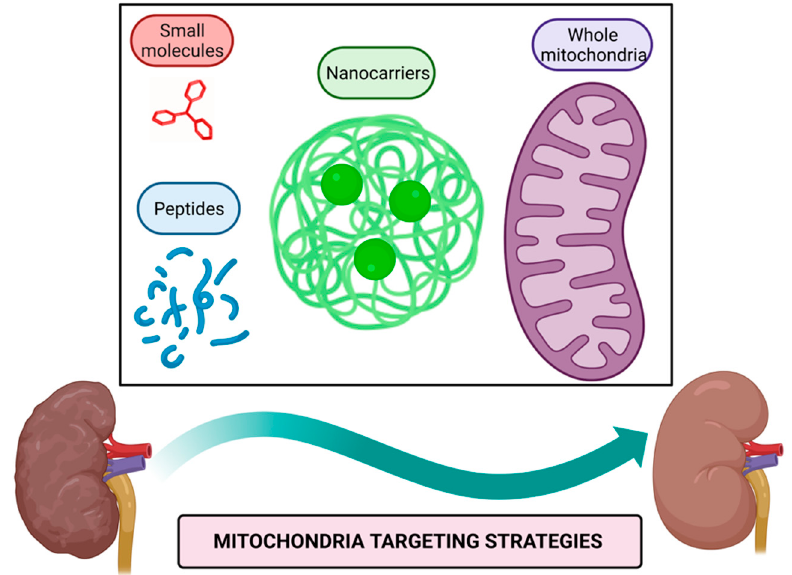
Figure 1. Mitochondria targeting strategies. Small molecules, peptides, nanocarriers, and whole mitochondria transplantation represent therapeutic strategies targeted to mitochondria to alleviate their dysfunction in kidney diseases. Figure created with BioRender.com.